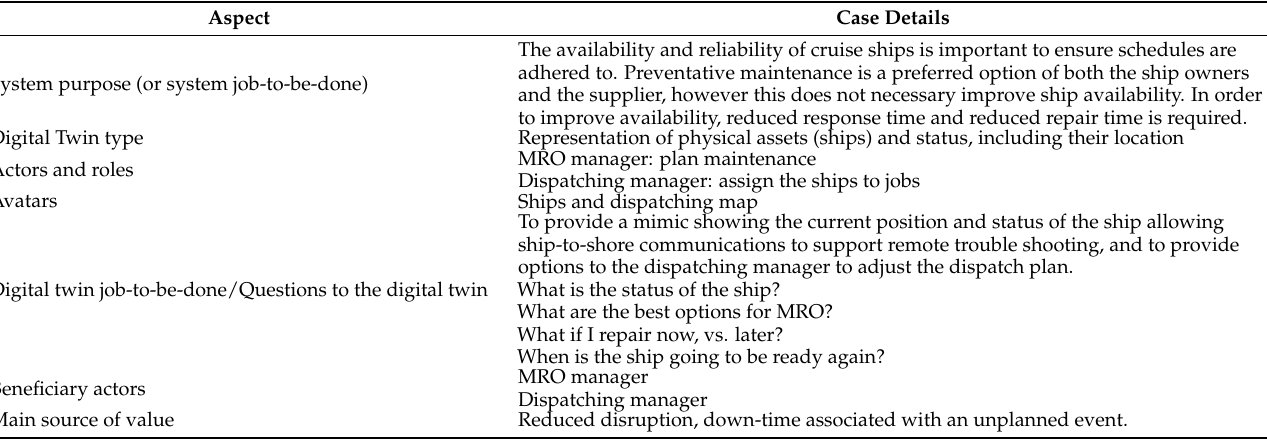
Table A8. Case 6—breakdown support twin for ships.